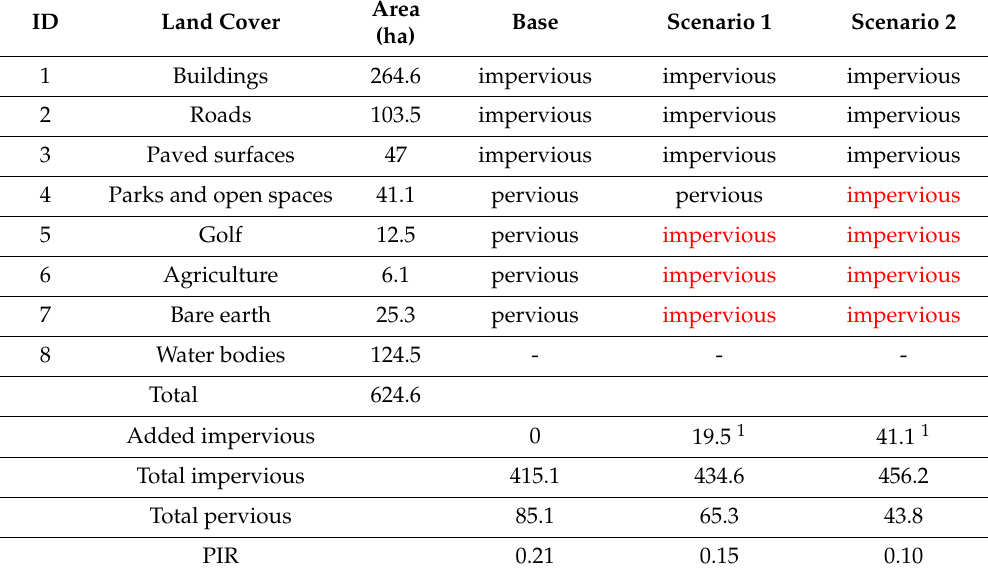
Table 5. Land cover data of Montreal at the year 2016 and its projected changes due to the urban growth for two